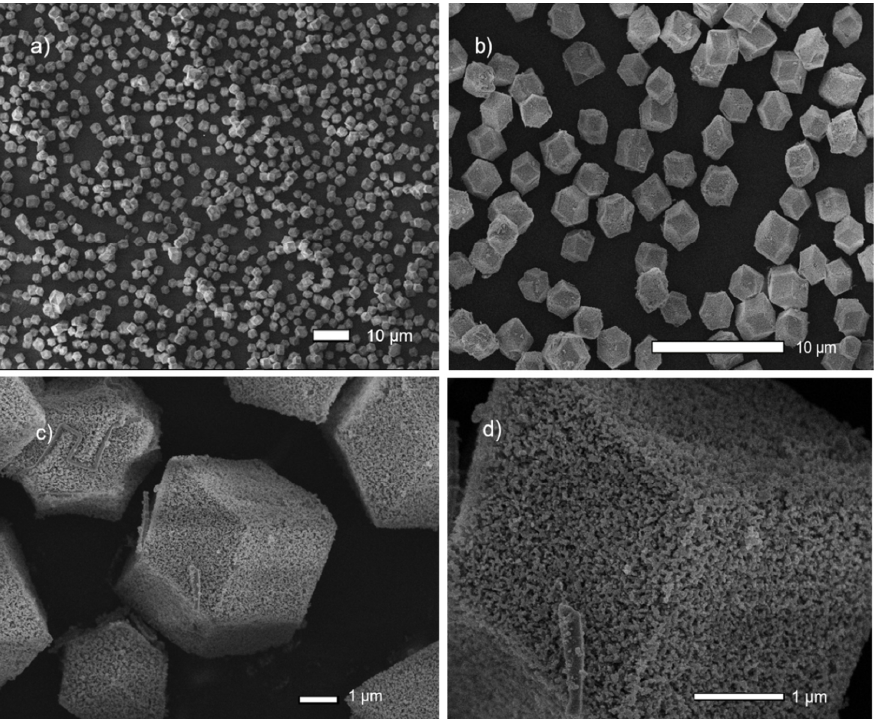
Figure 3. SEM-FEG images of the RCA compound obtained in this work. ( a – d ) are the composite of the RCA at different microscope magnifications.